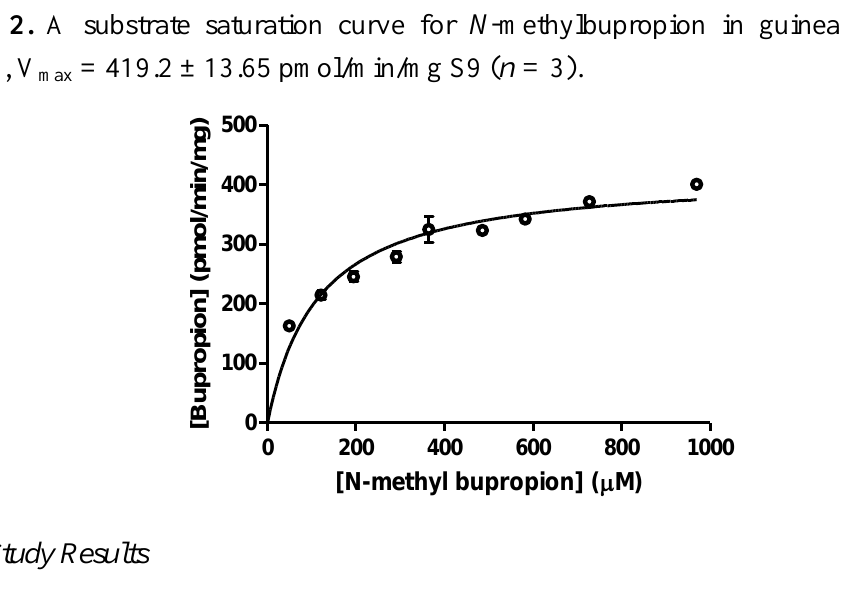
Figure 2. A substrate saturation curve for N -methylbupropion in guinea pig S9 liver